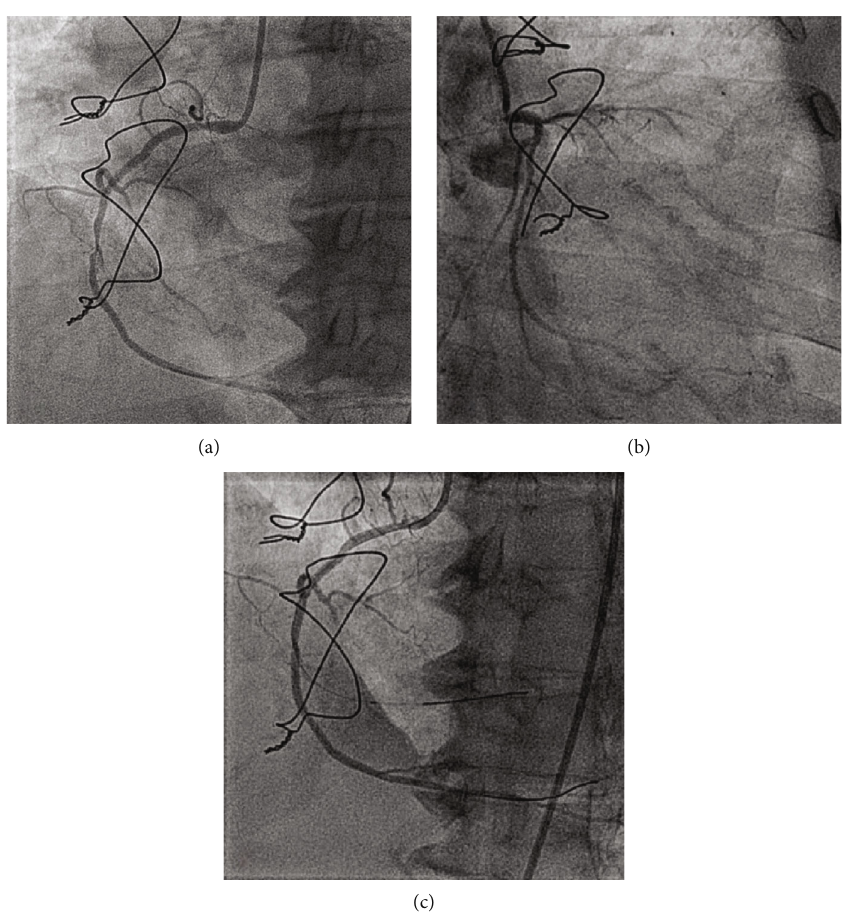
Figure 4: CAG showing (a) di ff usely diseased RCA with maximum stenosis of 80 – 90% at the mid part with 100% occlusion of AM, (b) CTO of LAD from the mid part and small caliber Left circum fl ex artery, and (c) TIMI 3 fl ow after RCA